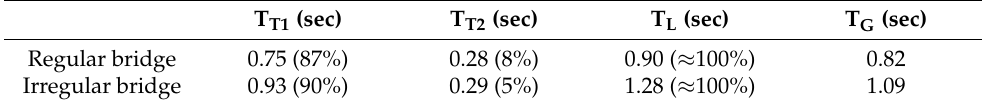
Table 1. Modal properties of bridges including periods and (effective modal mass ratios).